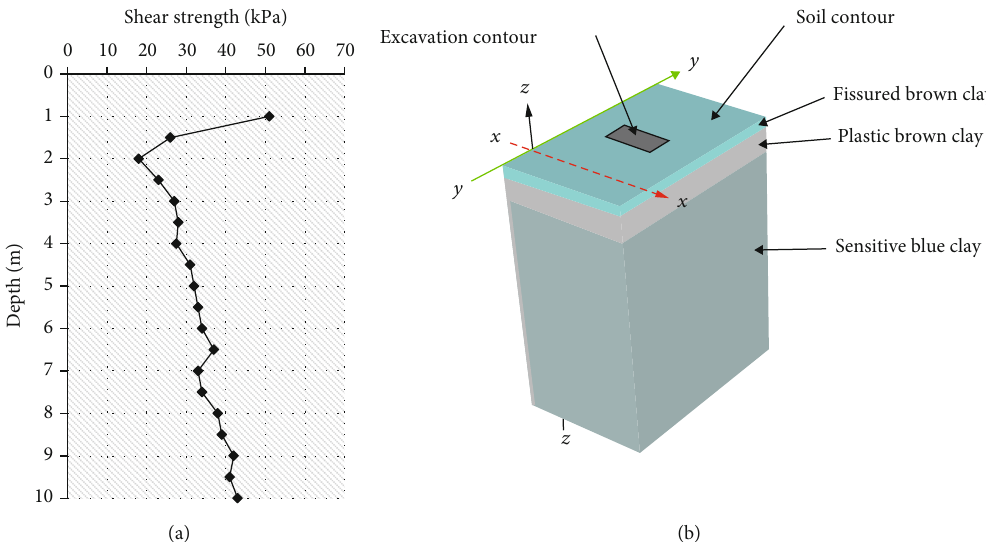
Figure 1: Geometric pro fi le and excavation contour in PLAXIS-3D simulation of trench: (a) experimental values of soil shear strength at Louiseville site (data adapted from Laval University); (b) PLAXIS-3D model pro fi le for Louiseville soil (number of soil elements: 23,221; MC soil model).